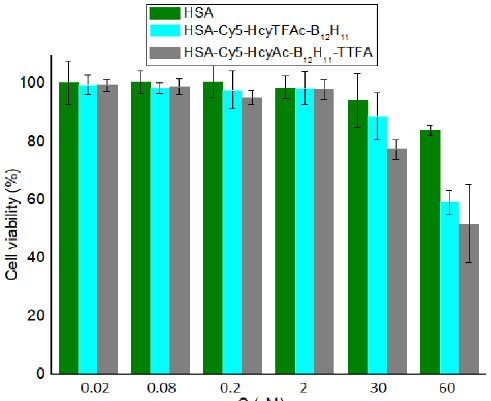
Figure 3. Viability of T98G cells. The cancer cell line was incubated for 72 h with HSA (green), HSA-Cy5-HcyTFAc-B 12 H 11 (cyan), and HSA-Cy5-HcyAc-B 12 H 11 -TTFA (gray) at various concentrations. After incubation, the cell viability was measured using the MTT test. The reported values represent the mean ± SD ( n = 3). Two-way ANOVA was used for comparisons of more than two sets of data. Differences were considered to be significant if the p -value was <0.05.